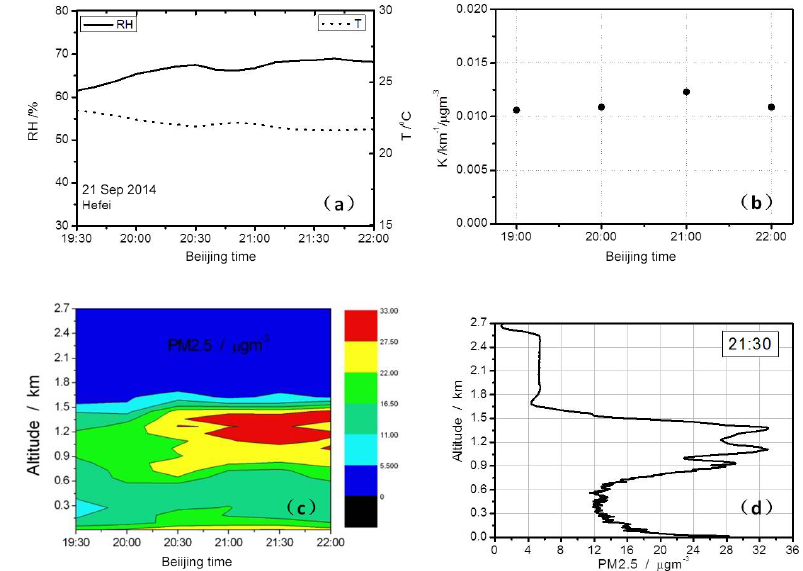
Figure 3. (a) RH and T parameters with time, (b) K value for each hour, (c) time series of PM 2 . 5 profile, and (d) vertical distribution of PM 2 . 5 at 21:30BT measured at the Hefei site on 21 September 2014.